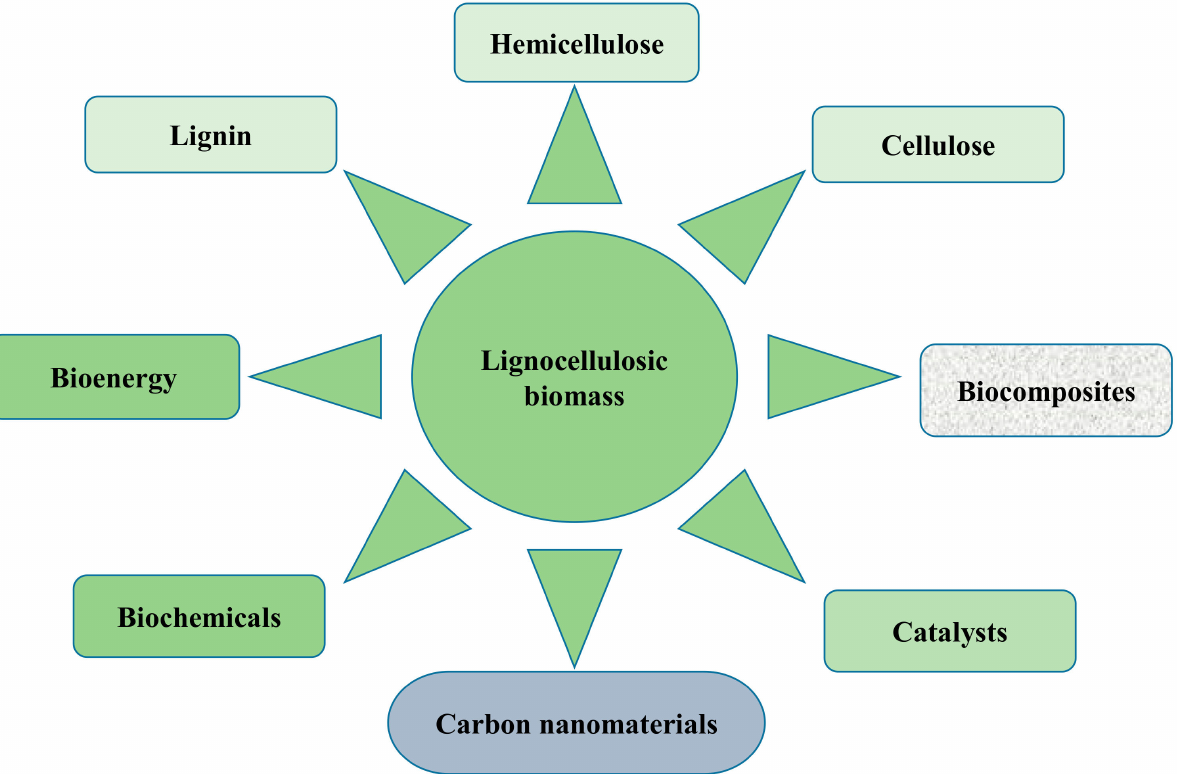
Figure 1. A schematic showing some of the possible extracts from